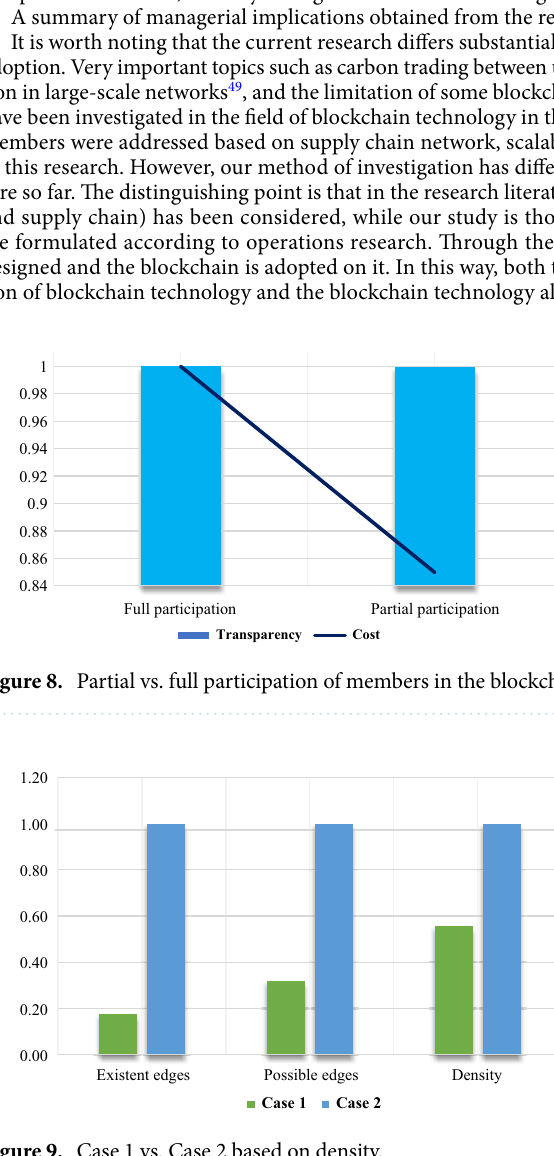
Figure 9. Case 1 vs. Case 2 based on